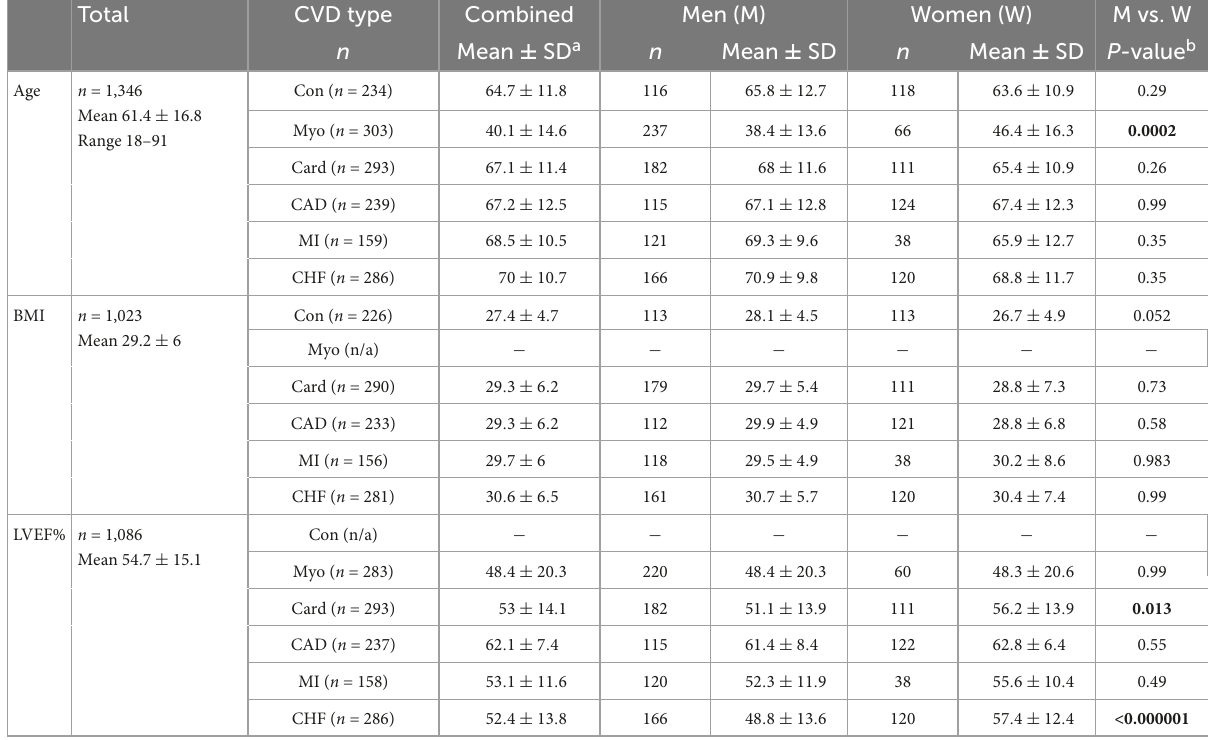
TABLE 1 Demographics of controls and patients with CVDs according to sex ( n = 1346, 60.8% male). Total CVD type Combined Men (M) Women (W) M vs. W n Mean ± SD a n Mean ± SD Mean ± SD P- value b Age n = 1,346 Mean 61.4 ± 16.8